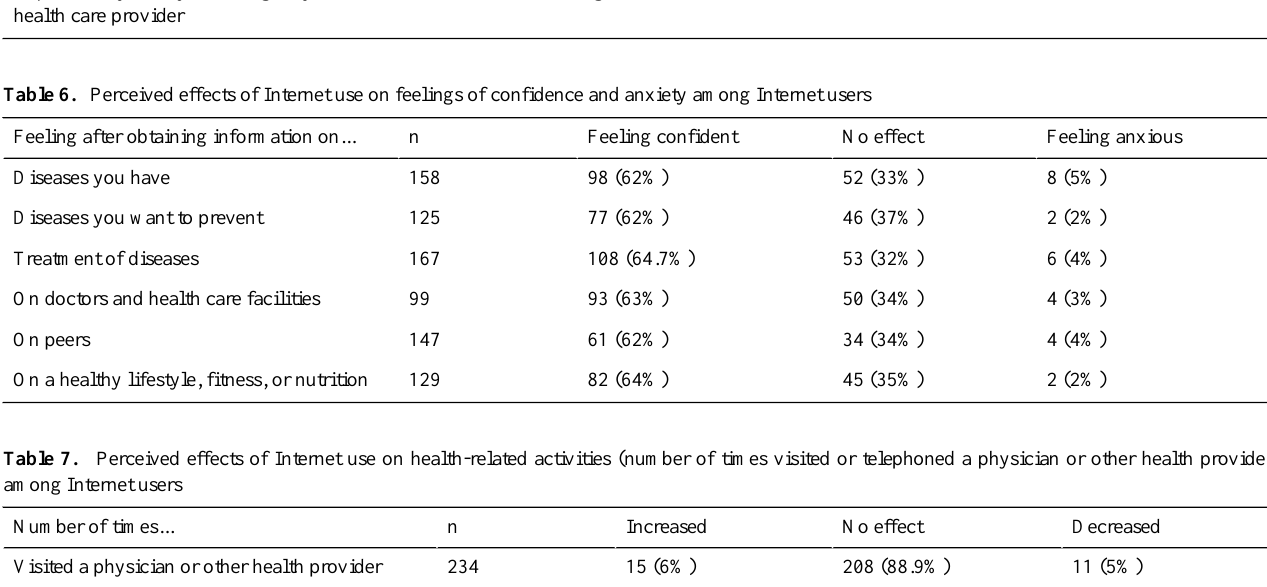
DecreasedNo effectIncreasednNumber of times...